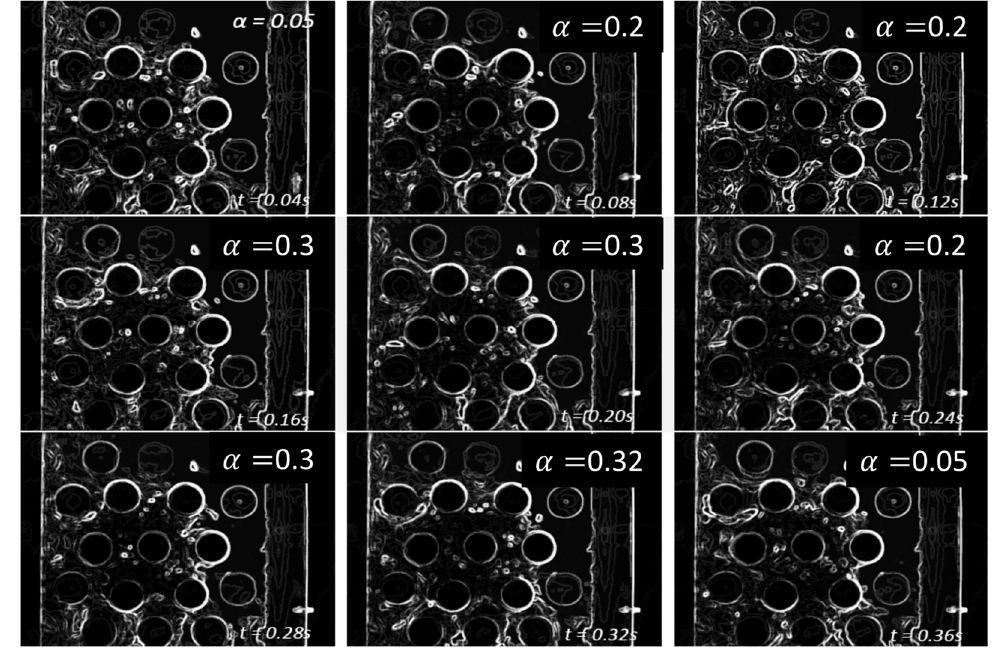
Figure 22. High-speed images of the flow at an air flow rate of 10 L/min and the approximate void fraction found using these images.